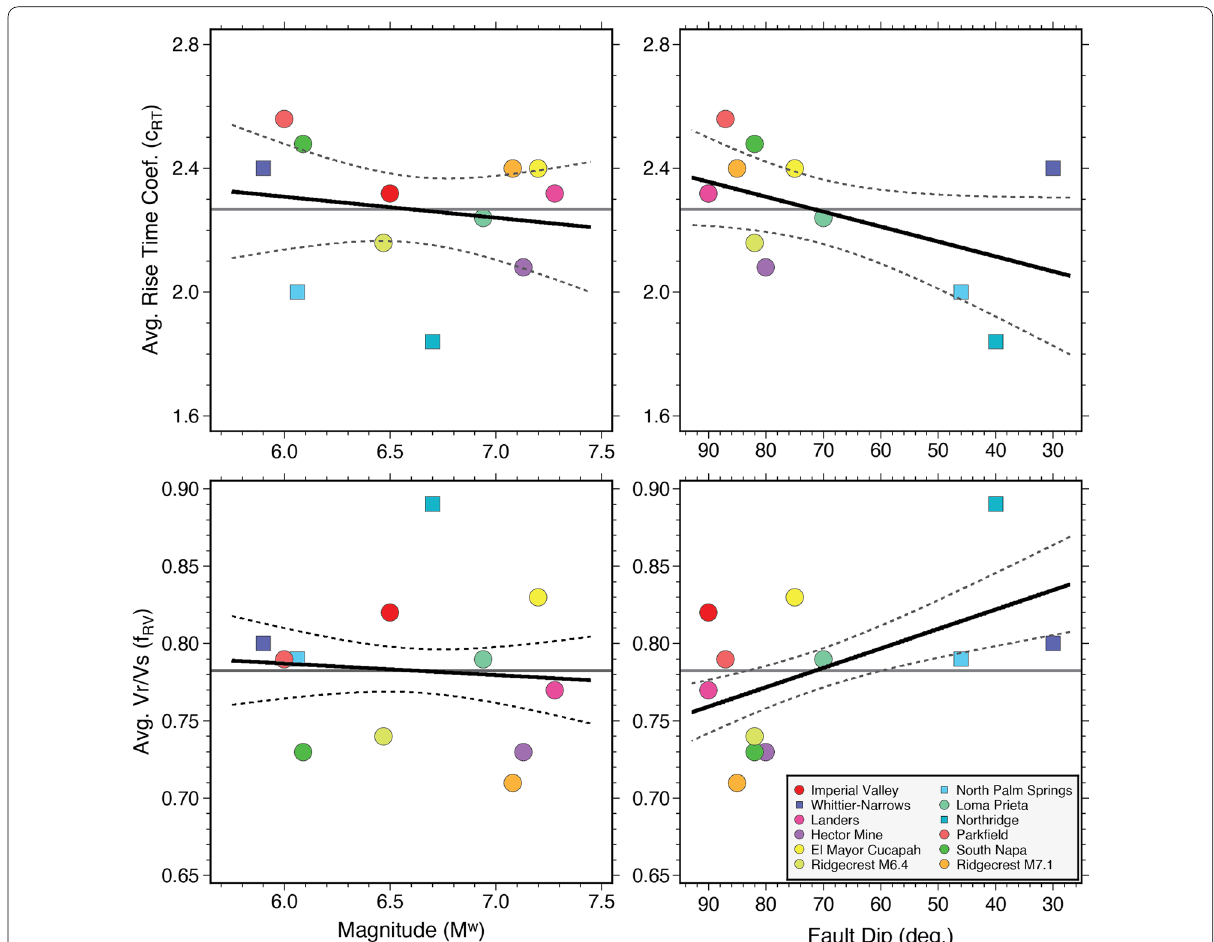
Fig. 14 Mean value of c RT (top row) and f RV (bottom row) across the five lowest misfit realizations for each of the 12 validation events plotted as a function of magnitude (left column) and fault dip (right column). In each panel, the horizontal gray line is the average of the data points and the solid and dashed black lines are linear regression fits to the points and 95% confidence bounds, respectively. Symbols are plotted at the mean value of the respective parameter for each earthquake, however, regression fits and confidence bounds are determined using values from the five lowest misfit realizations as input data